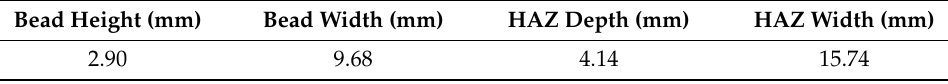
Figure 5. Define the shape of cross section and key parameters. Table 4. Values of key parameters.